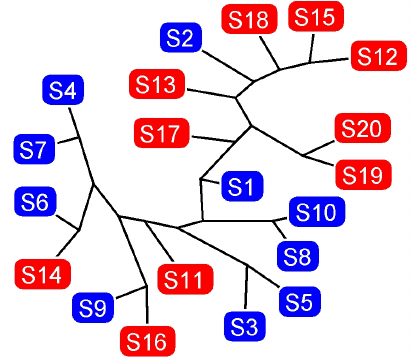
Figure 1. Output of eyePatterns – a tree-graph constructed by a hierarchical clustering algorithm